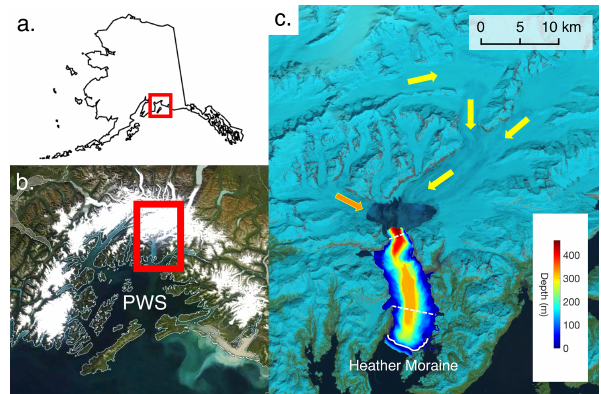
Figure 1. Columbia Glacier. (a) Outline of Alaska. (b) NASA MODIS image of Prince William Sound (PWS) from WorldView satellite. (c) Landsat image of Columbia Glacier and Fjord in 2013. Yellow arrows indicate flow of the main branch of the glacier. The orange arrow indicates flow of the west branch of the glacier. Heather Island is visible along Heather Moraine. The white line in- dicates the location of Heather Moraine. Dashed lines delineate the boundaries between the proximal zone, the mid-fjord zone, and the distal zone. The bathymetry, measured by the NOAA ship Rainier in 2005, is overlain on the lower portion of Columbia